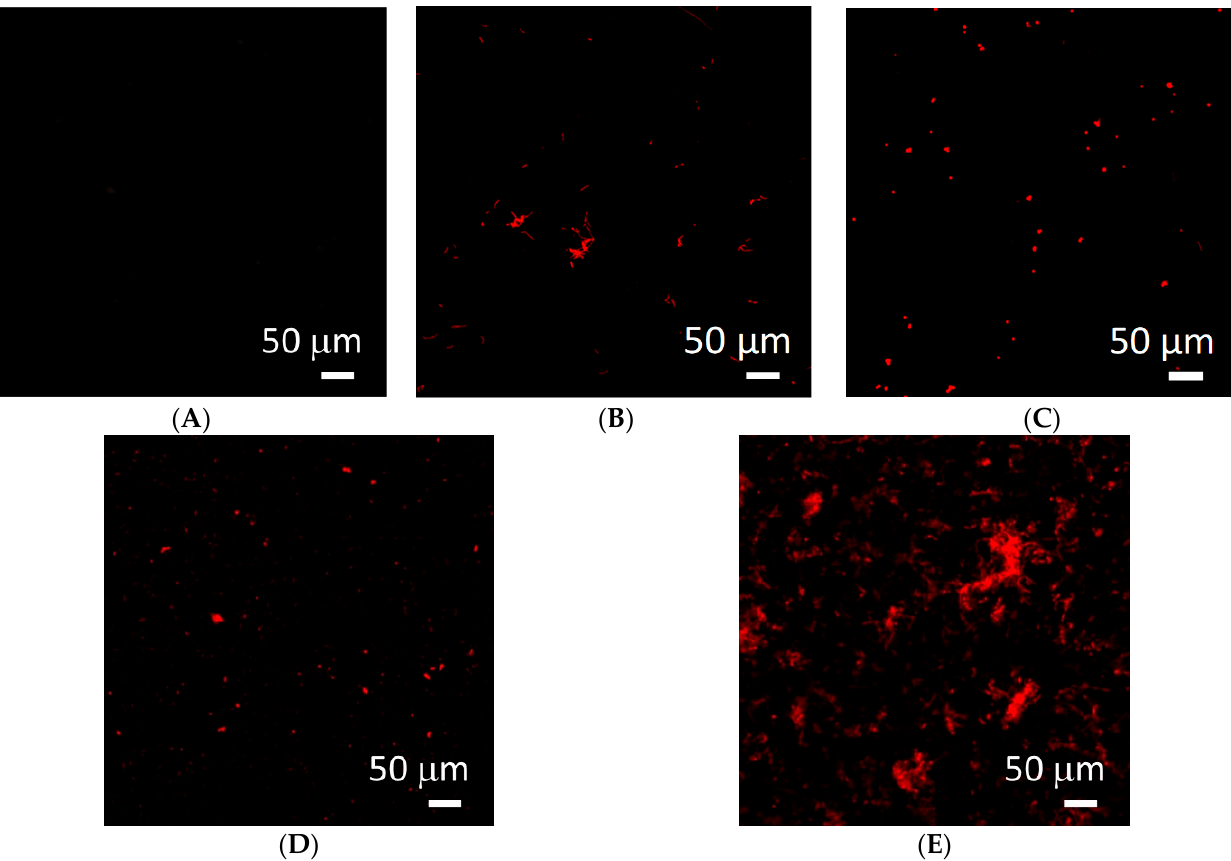
Figure 6. The viability of bacteria on the surface of the tested biomaterials. ( A ) Reference substrate, ( B ) Ti/TiN + 5% Ag, ( C ) Ti/TiN + 7.5% Ag, ( D ) Ti/TiN + 10% Ag, ( E ) Ti/TiN + 15% Ag.